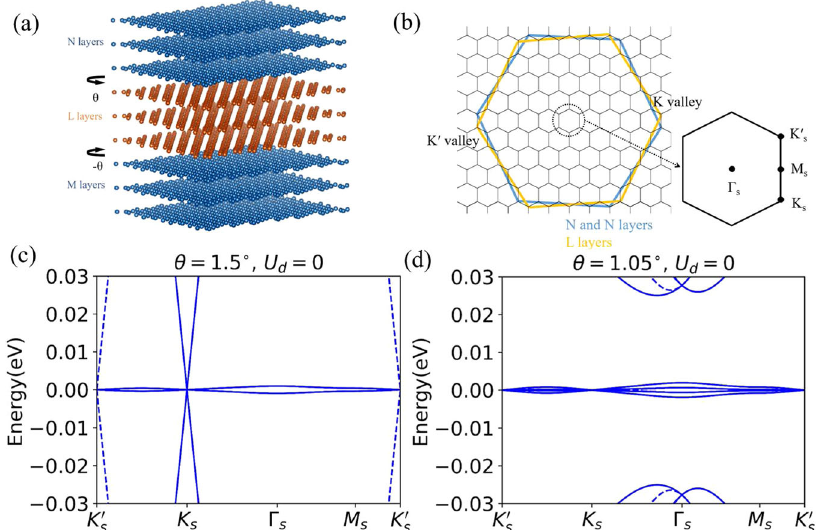
Fig. 1 Schematic and single particle band structures of ATMG systems. a Lattice structure of alternating twist multilayer graphene. b Brillouin zones of M , L and N layers and Moiré Brillouin zone with high symmetry points. Band structure of c A - A - A and d A - ABA - A at K valley (solid line) and K 0 valley(dashed line) in the chiral limit, considering nearest neighbor interlayer hopping with zero displacement fi